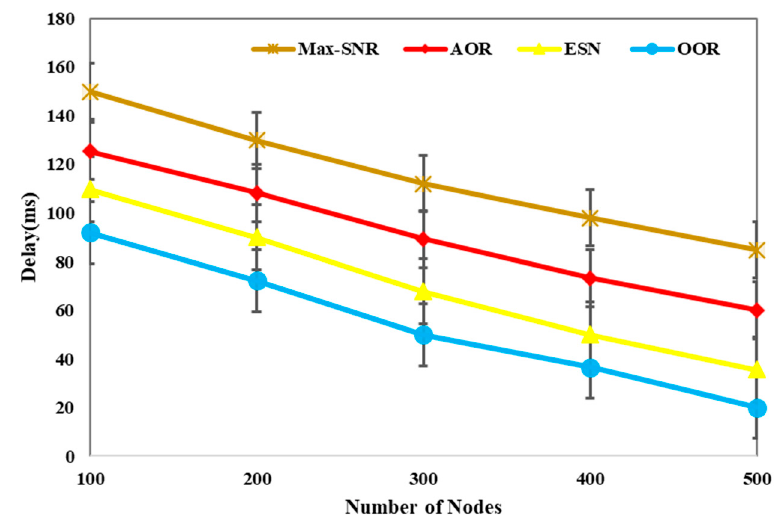
Figure 4. Delay comparison with varying number of nodes.